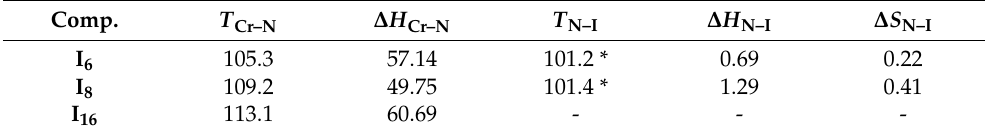
Figure 2. Nematic texture of I 8 derivative upon cooling round at 99 °C under POM. Table 1. Transition temperatures (°C), enthalpy in kJ/mol, and normalized entropy of transitions for series I n .